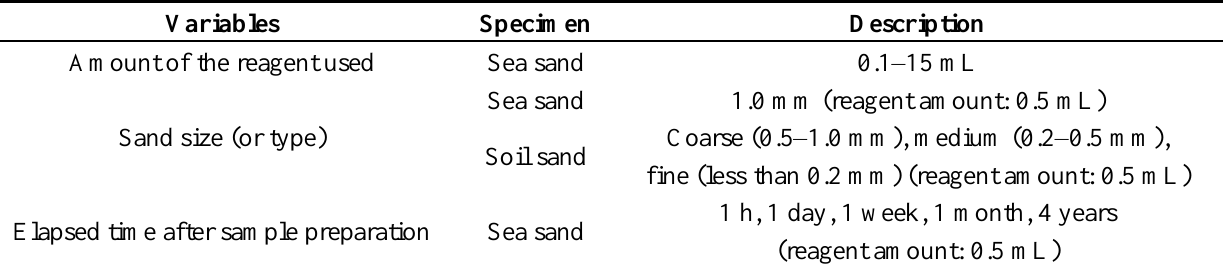
Figure 3. Experiment setup and the reaction zone for uranium extraction from the contaminated sand: (1) CO 2 cylinder; (2) syringe pump; (3) mixing cell; (4) preheating cell; (5) specimen; (6) mixer; (7) thermostat; and (8) collector. Table 1. Conditions for the extraction